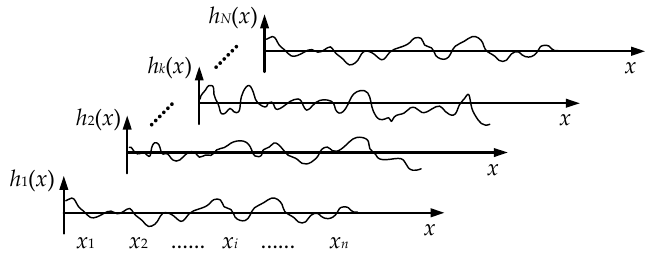
Figure 9. Schematic diagram of stochastic process on corroded surface.